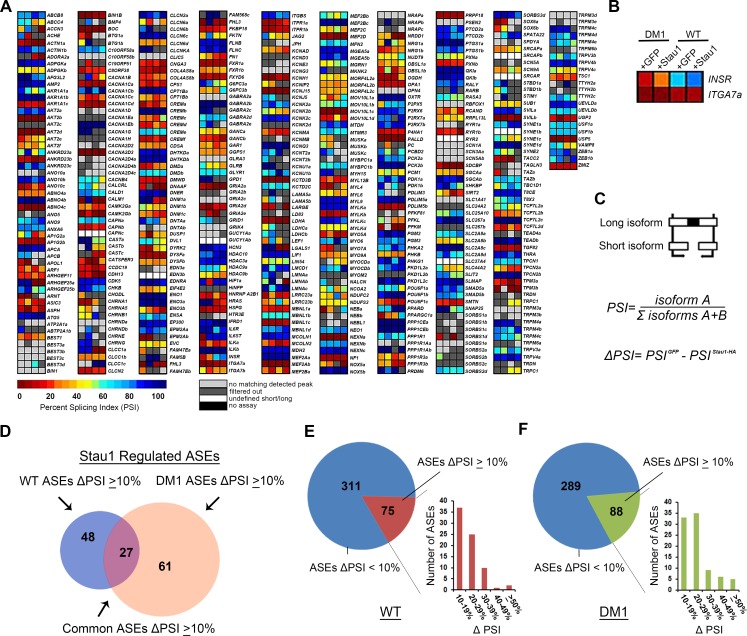
Analysis of high-throughput RT-PCR splicing screen.(A) Raw data output displayed as heatmap from RT-PCR splicing screen. A total of 489 ASEs were analysed in the high-throughput RT-PCR Screen. Any ASEs that showed a blank reading for Percent Splicing Index (PSI) in any of the four conditions was excluded. (B) Enlarged image of two ASEs in DM1 and WT conditions. (C) PSI represented here as a ratio between the long isoform and the short isoform. The changed in PSI (ΔPSI) was calculated for each ASE in both conditions. (D) Total number of ASEs that showed a PSI change ≥10% with Stau1-HA overexpression in WT and DM1. (E-F) Stau1 and non-Stau1 (<10% ΔPSI) regulated ASEs. Bar graphs display the ΔPSI groups (according to percent change) of Stau1-regulated ASEs in both WT and DM1.